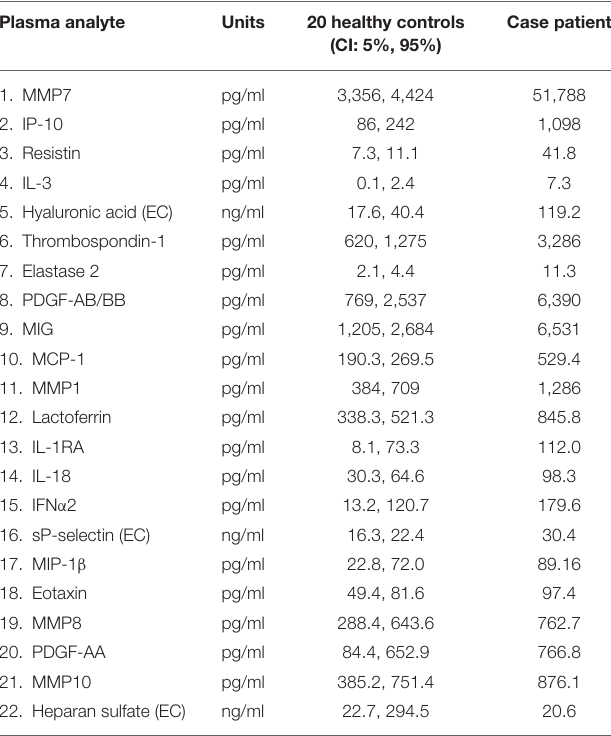
TABLE 1 | Significant analyte concentration changes for the COVID-19 case patient and 20 healthy control subjects (EC, endothelial cell). Plasma analyte Units 20 healthy controls (CI: 5%,